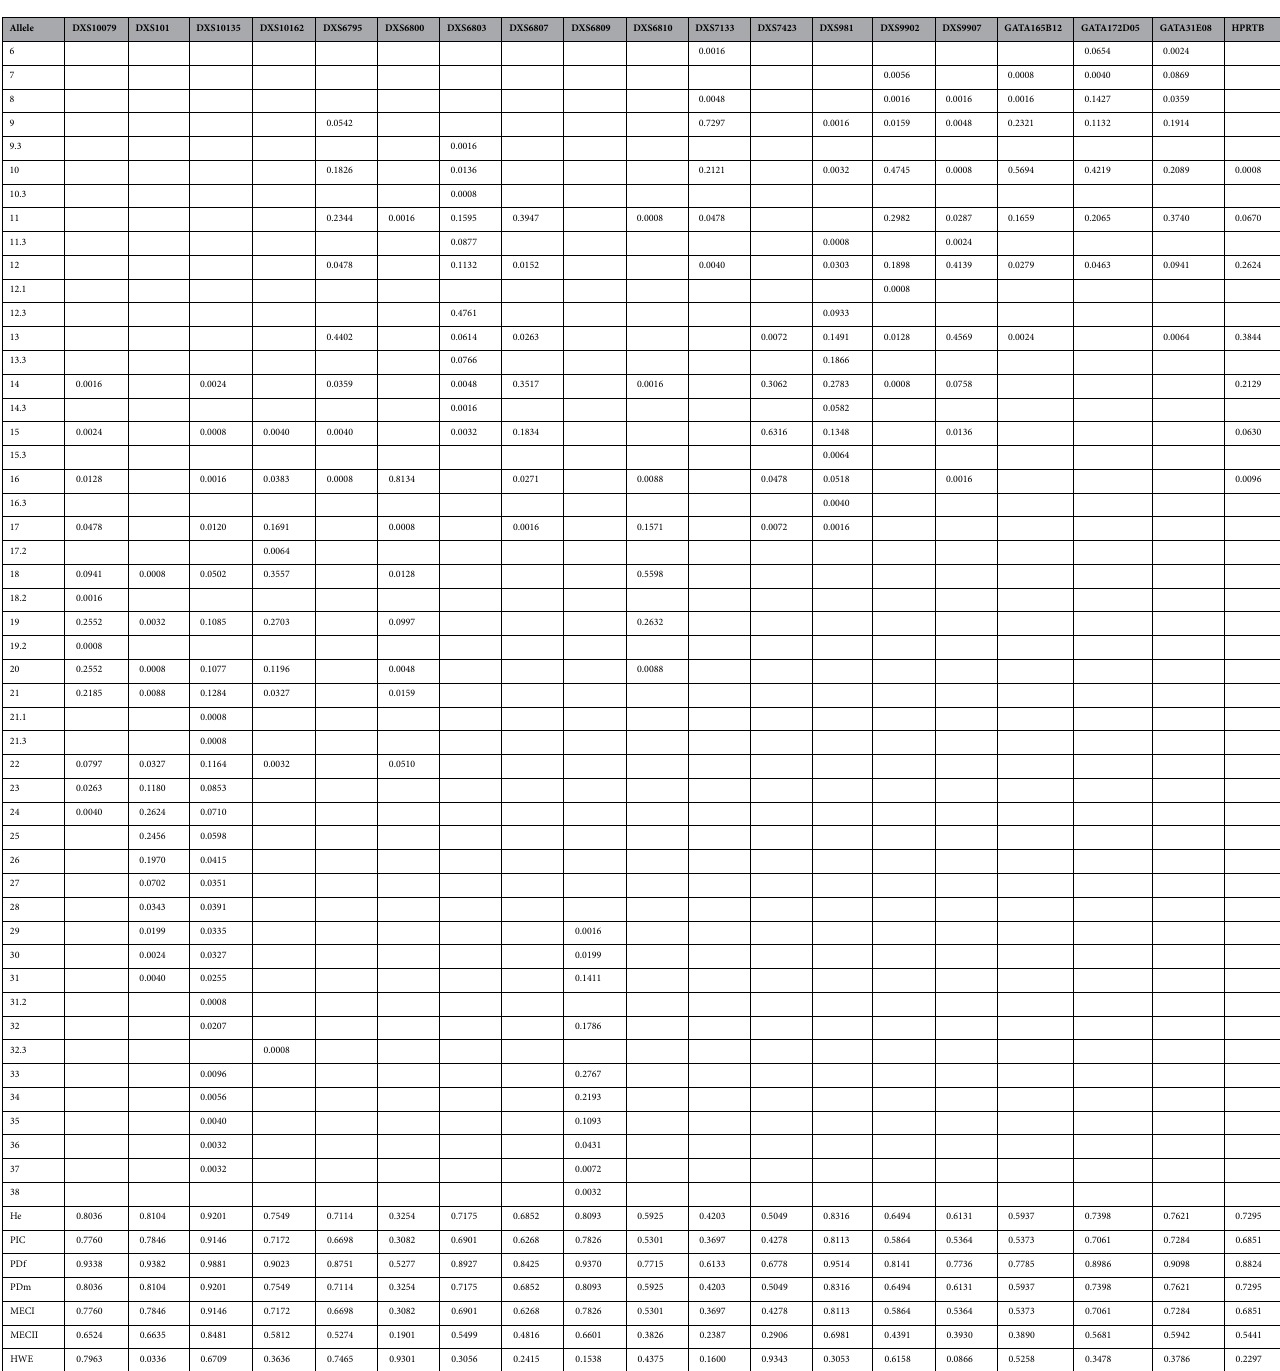
Table 3. Allele frequency of 19 X-STR loci and forensic parameters based on 985 unrelated individuals. He, expect heterozygosity;PIC, polymorphism information content; PD f ,power of discrimination in females; PD m , power of discrimination in males; MECI , mean exclusion chance for X-STR in standard trios with daughters;MECII , mean exclusion chance for X-STR in father/daughter duos;HWE, P-values for Hardy– Weinberg